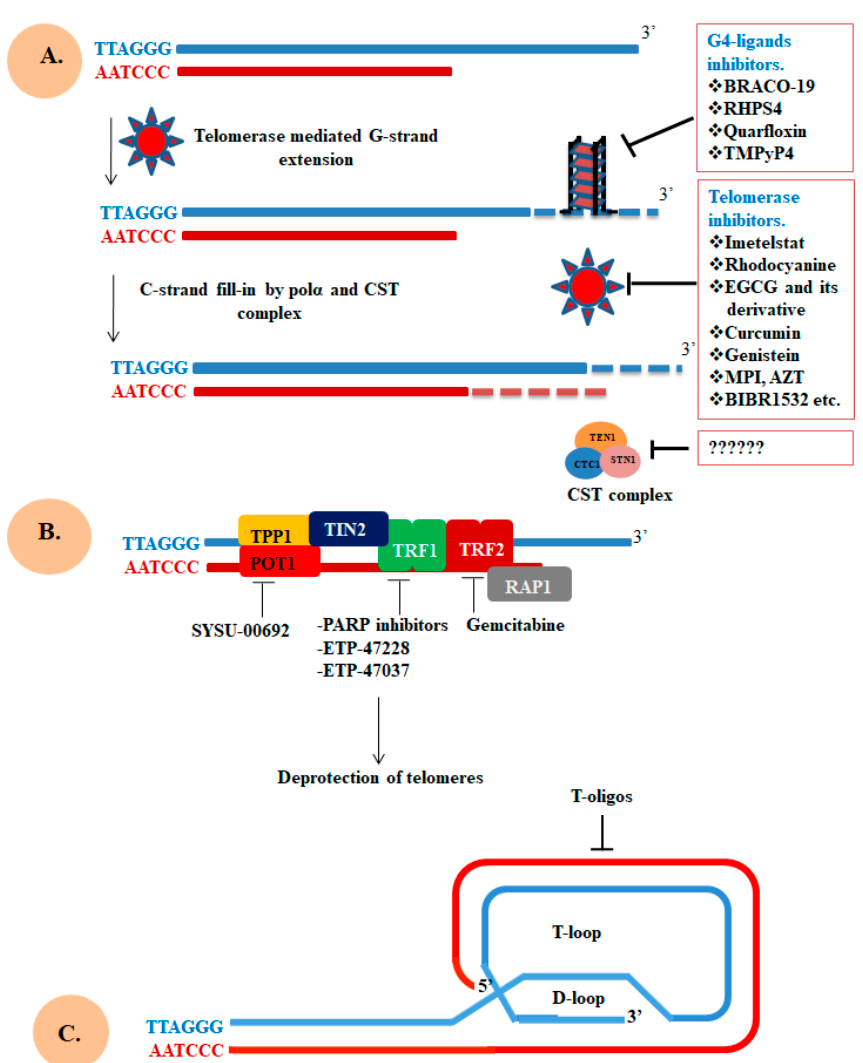
Figure 4. Molecular target directly affecting the integrity of telomere. ( A ) G4-ligands bind with Figure 5. Molecular target directly a ff ecting the integrity of telomere. ( A ) G4-ligands bind